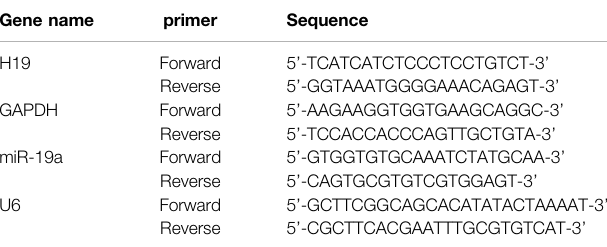
TABLE 1 | The sequences of primers.